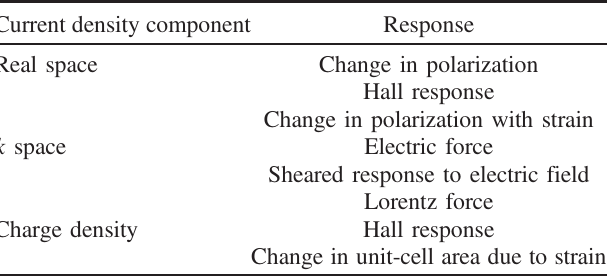
TABLE III. Summary of responses from 4D phase space. Current density component